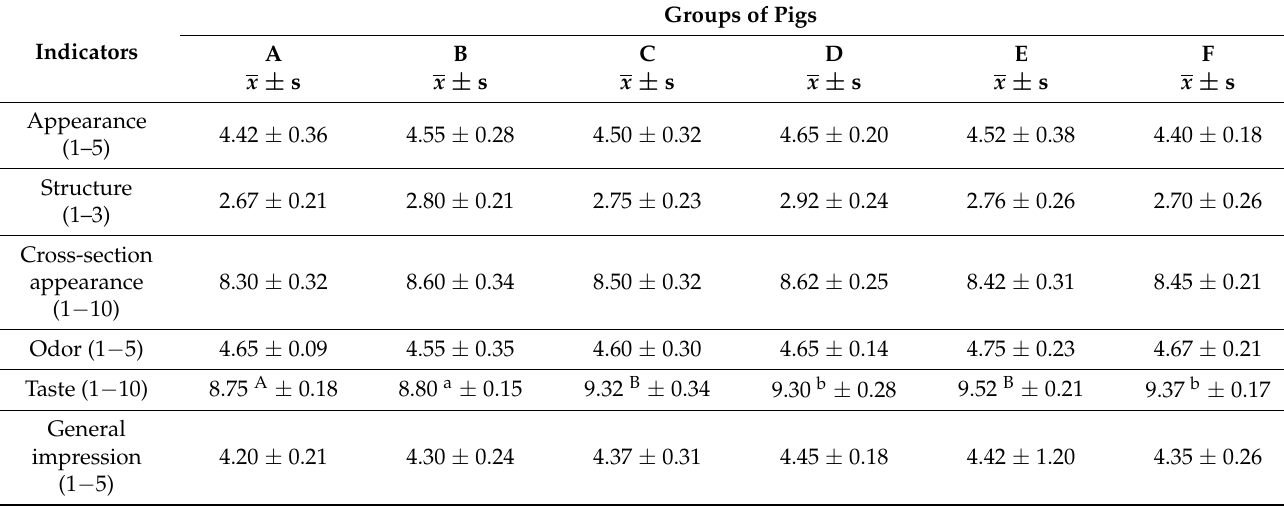
Table 12. Sensory properties of